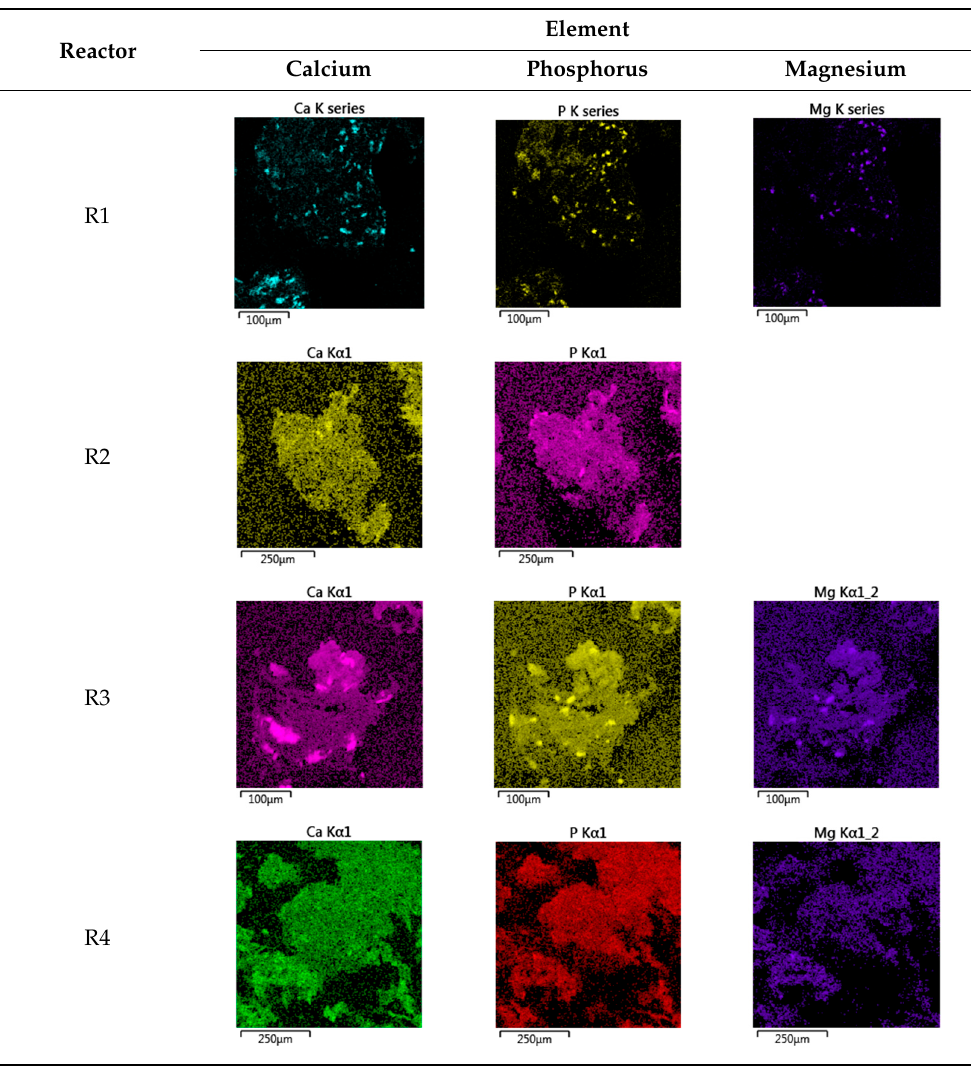
Table 3. Map of the distribution of selected chemical elements in the area of granules.